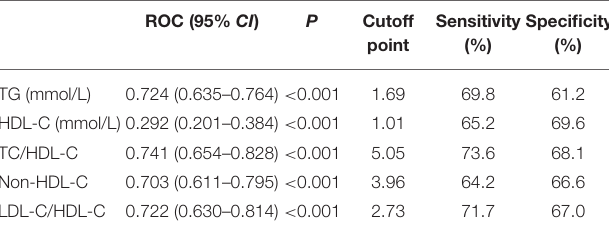
Sensitivity Specificity point (%) (%)